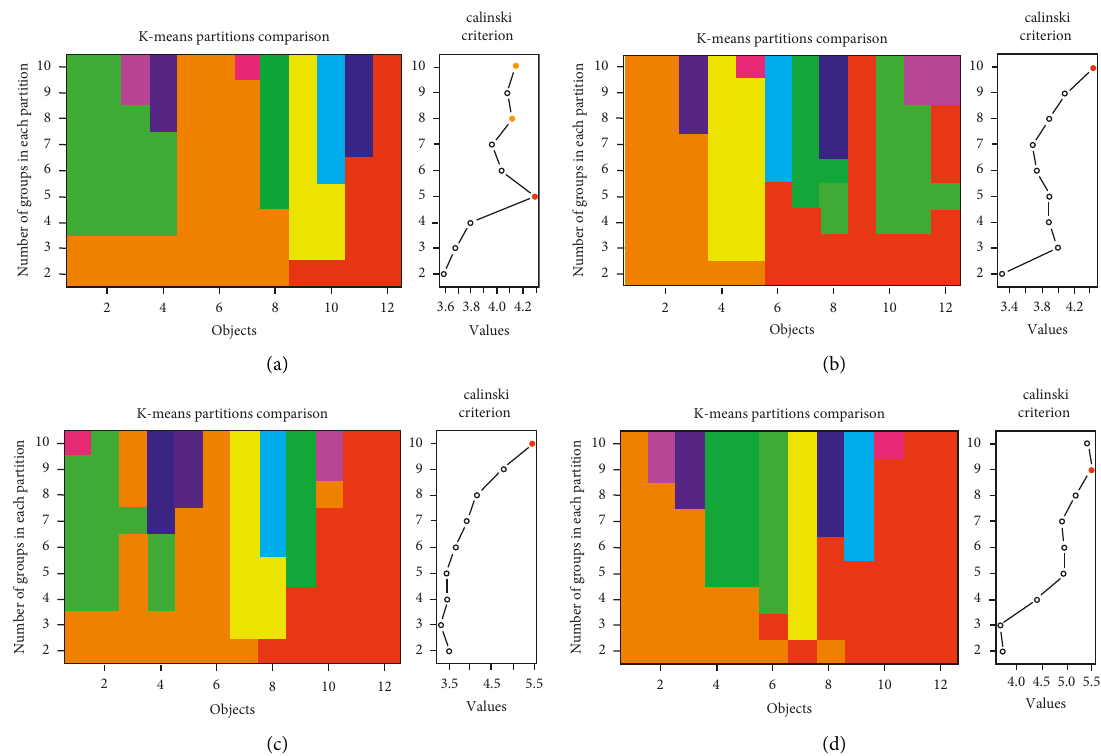
Figure 4: The number of clusters provided by Calinsky criterion: (a) total number of crashes, (b) rear-end, (c) fixed-object hitting, and (d)